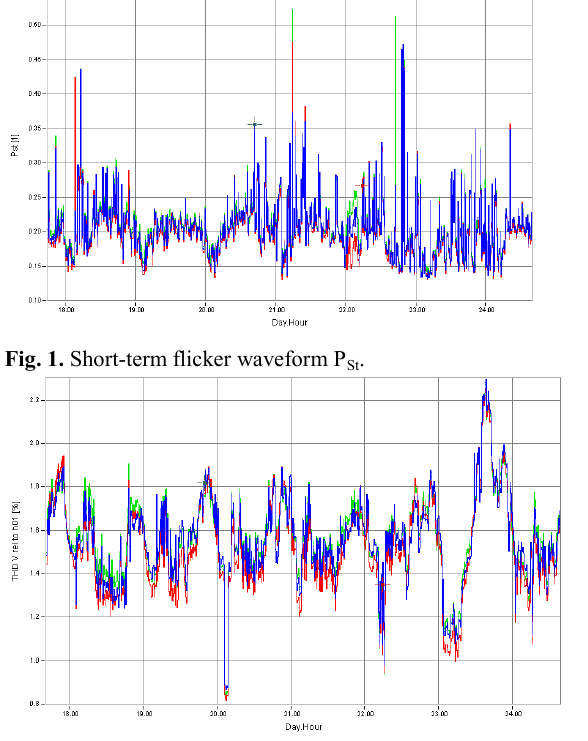
Fig. 2. Harmonic waveform - content of THD u